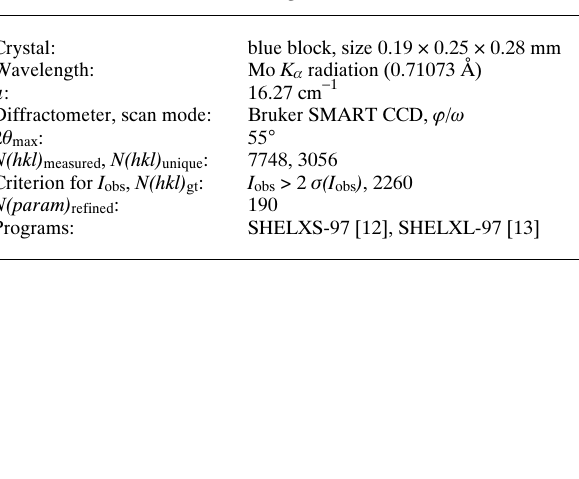
Table 2. Atomic coordinates and displacement parameters (in Å 2 ) . Table 1. Data collection and